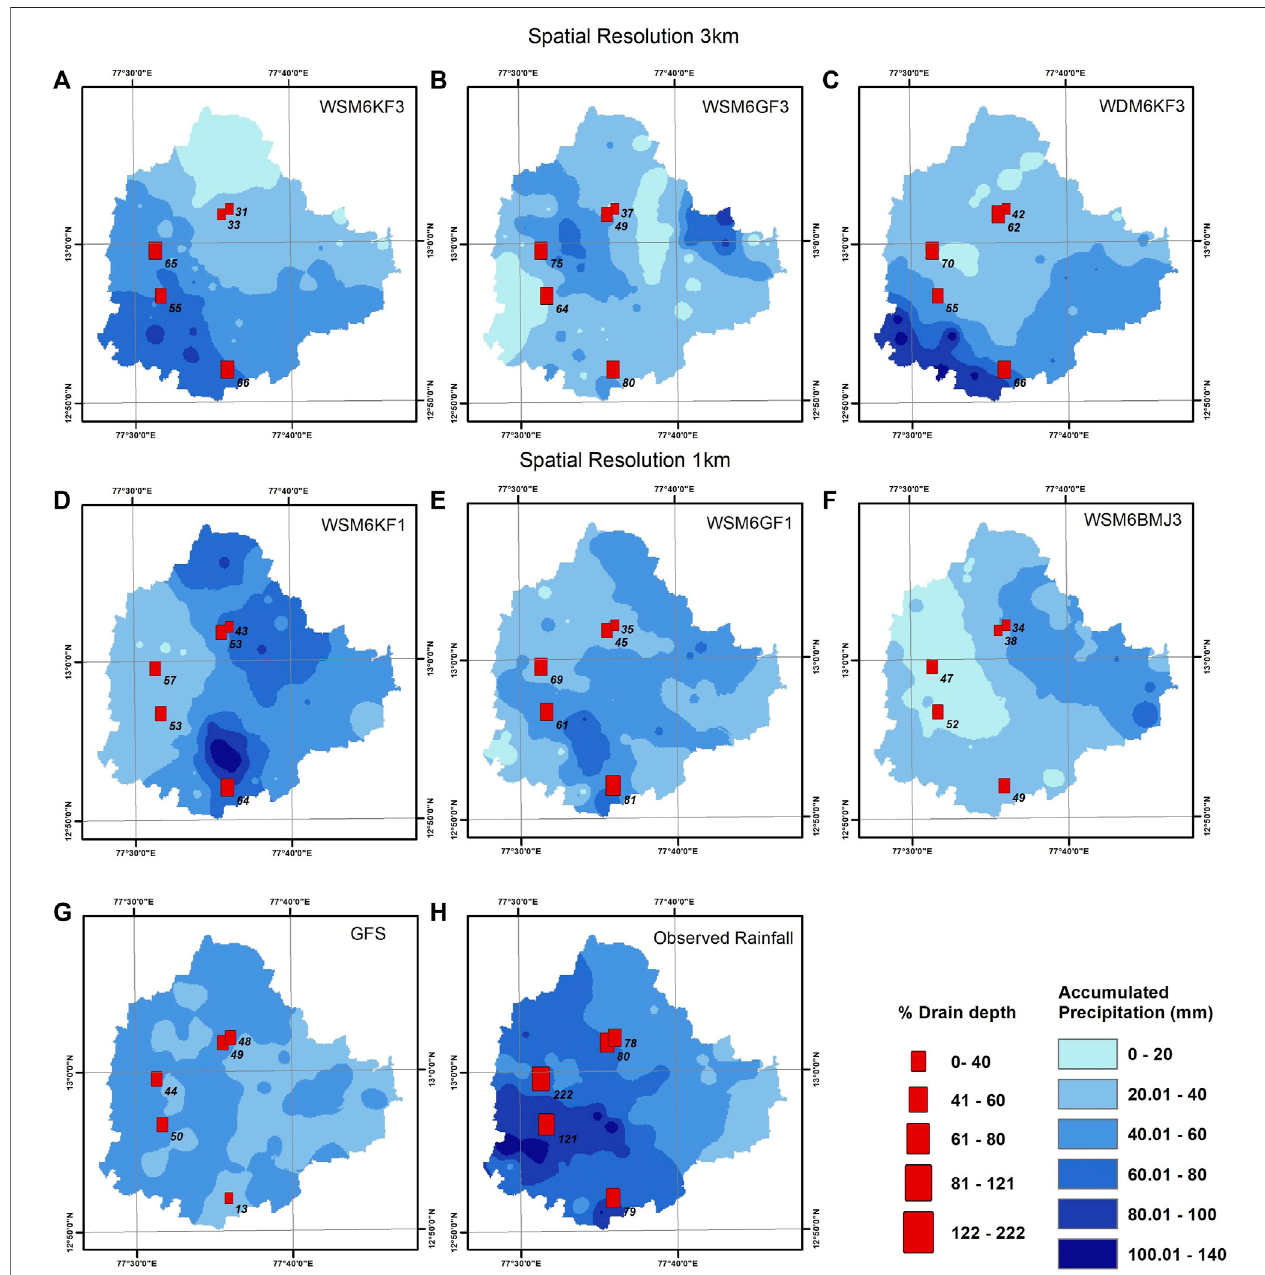
FIGURE 5 | Rainfall forecasts from WRF ensemble members and GFS forecast and the corresponding water level forecasts. (A – F) , Spatial variability in rainfall and corresponding fl ood forecasts from WRF ensemble member WSM6KF3 (A) , WSM6GF3 (B) , WDM6KF3 (C) , WSM6KF1 (D) , WSM6GF1 (E) , WSM6BMJ3 (F) , (G,H) Spatial variation in rainfall and corresponding fl ood forecasts from GFS (G) , and Observed ARGs (H) . The red boxes indicate the forecasted water levels at critical locationsbythemodelrepresentedaspercentage ofdraindepthoccupiedbywater.Thewaterlevelforecastsshowsimilaritywiththeobservedwaterlevelswhich are better than the forecasts using